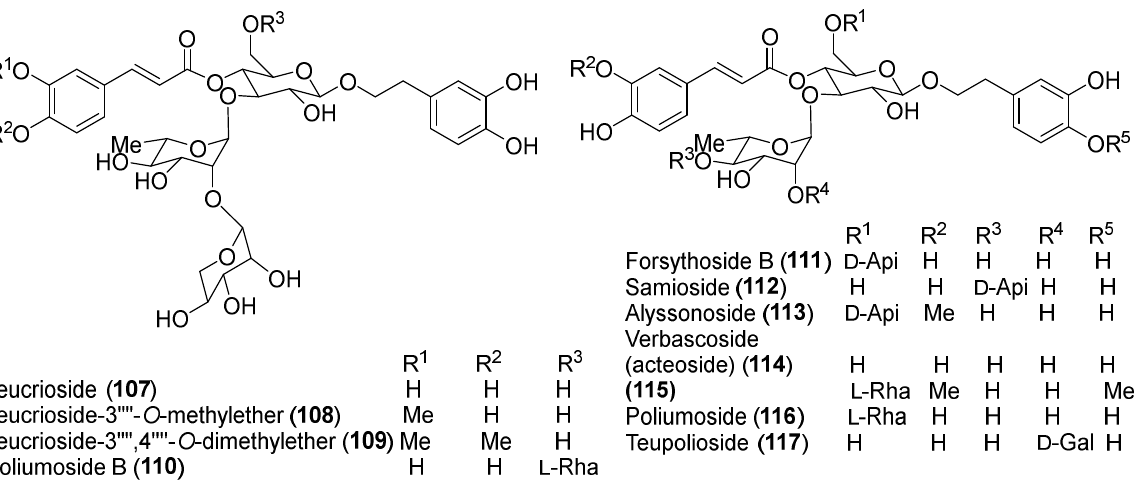
Figure 7. Representative verbascoside derivatives isolated from Teucrium chamaedrys and Teucrium polium.